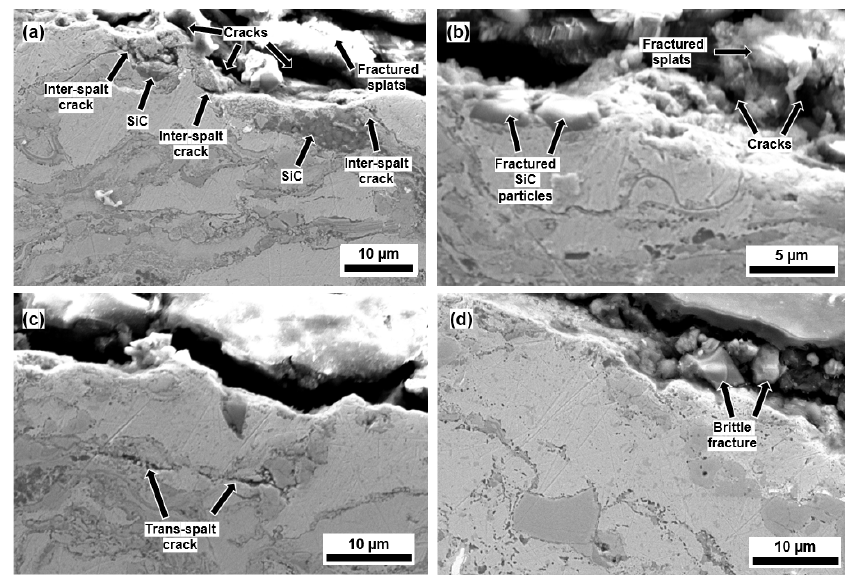
Figure 14. Cross section of eroded samples 90° at 900 °C. ( a–c ) C2; ( d ) C1.